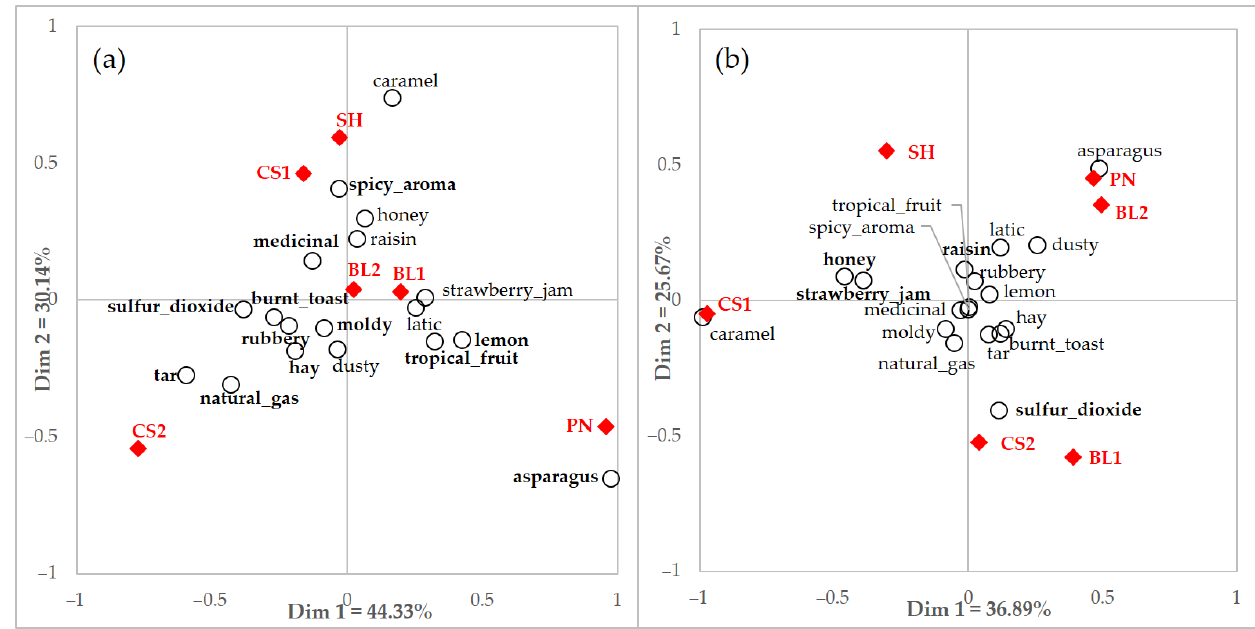
Figure 4. Correspondence analysis (CA) of ( a ) users and ( b ) non-users data with integrated significant terms ( n = 18) by CATA questionnaire of total consumers, users, and non-users. Filled diamonds indicate red wine samples and empty circles indicate attributes. Terms in bold indicate significant differences according to each consumer group with different familiarity.